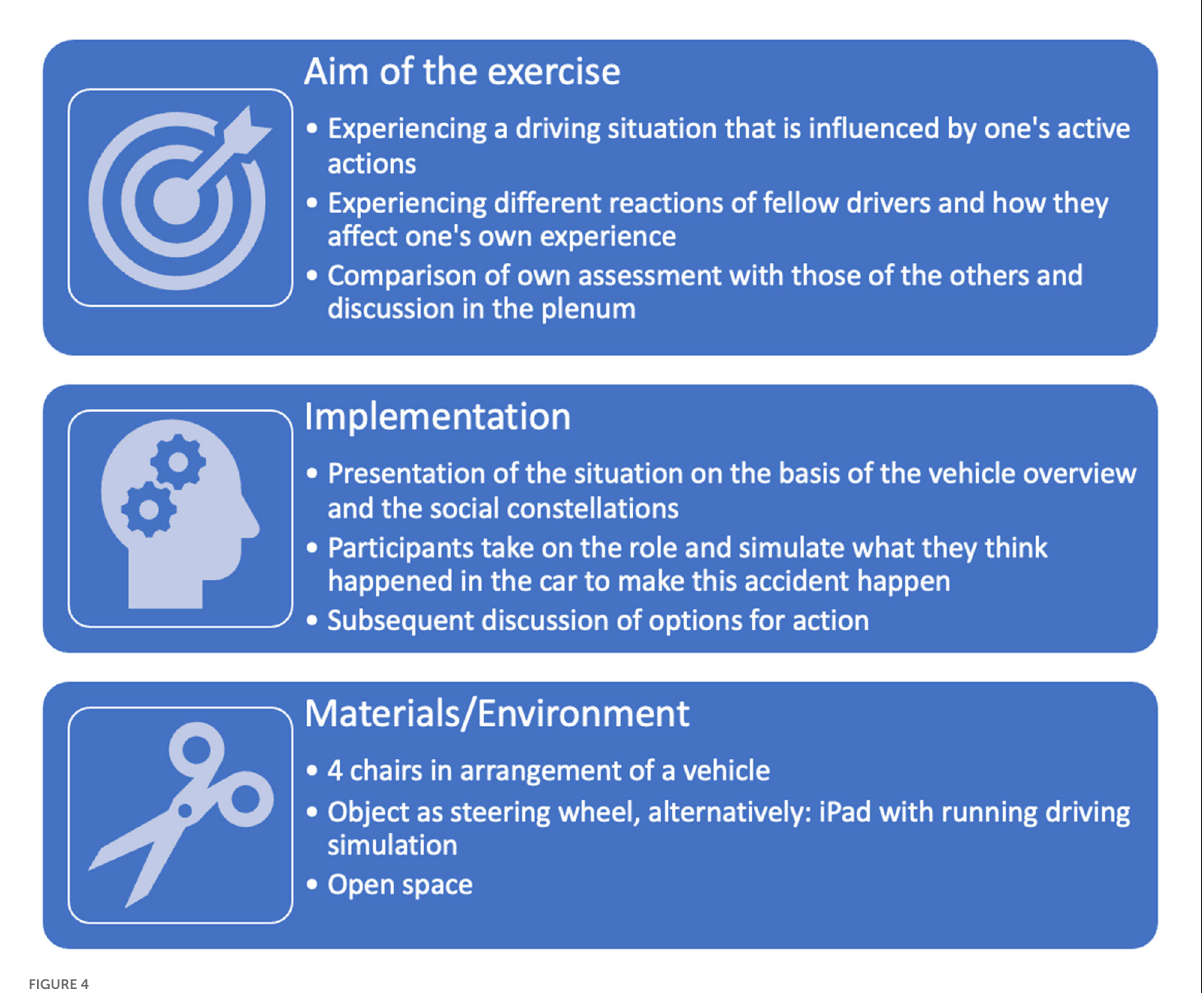
FIGURE4 Overview of the exercise “The last two